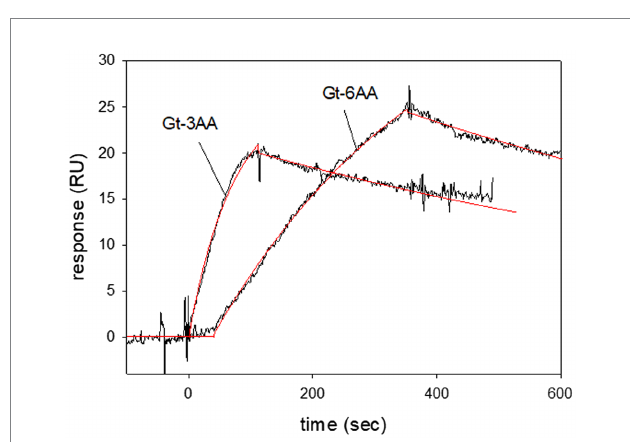
FIGURE 5 Surface plasmon resonance recordings of LWO2 interacting with truncated variants of Gt α /Gi α . Gt α /Gi α with a C-terminus truncated by three or six amino acids (Gt-3AA and Gt-6AA, respectively) was immobilized on a CM5 sensor chip. Peptide LWO2 was injected and flushed over the surface at a concentration of 120 nM (Gt-3AA) or 100 nM (Gt-6AA). Global curve fitting (Langmuir 1:1 binding model, red lines) resulted for Gt-3AA in an association rate